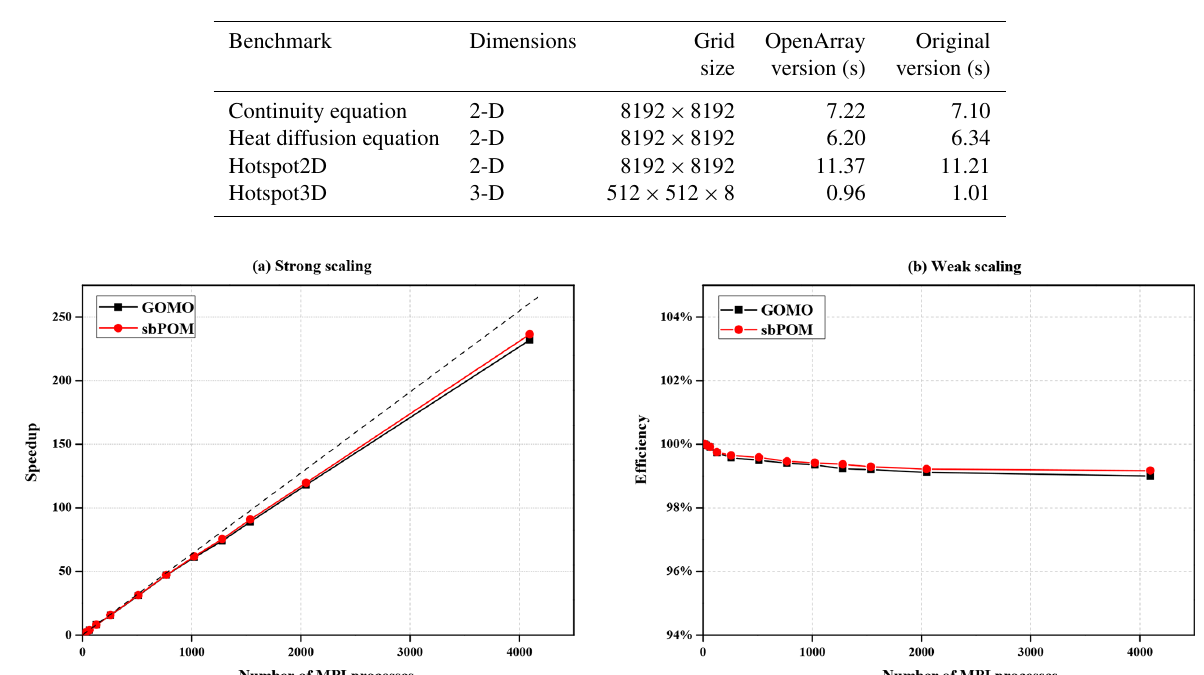
Figure 12. Performance comparison between sbPOM and GOMO on the X86 cluster. Panels (a) shows the strong scaling result; vertical axis denotes the speedup relative to 16 processes in a single node. Panel (b) shows the weak scaling result.